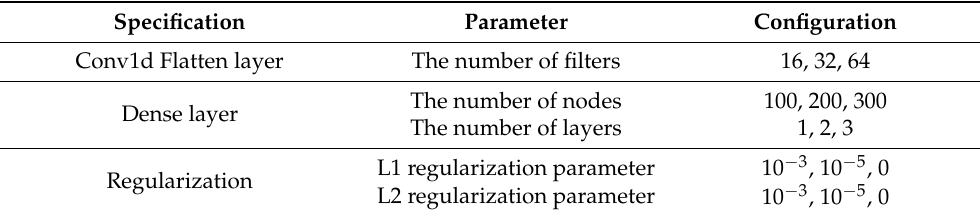
Table 2. Parameters with structure of the convolutional neural network (CNN) model used to find an optimal model for estimating SSI derived from